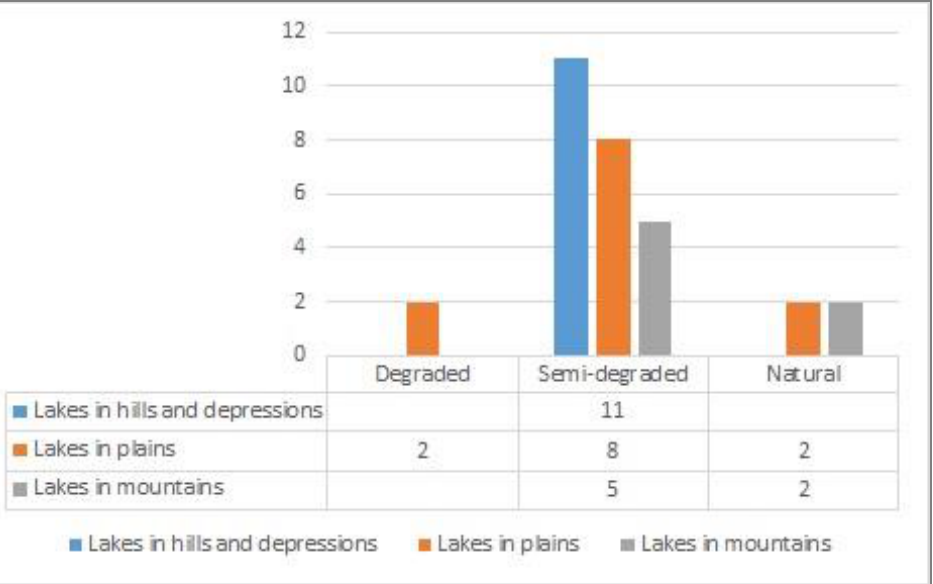
Figure 11. Degradation state in relation to major geographic units.